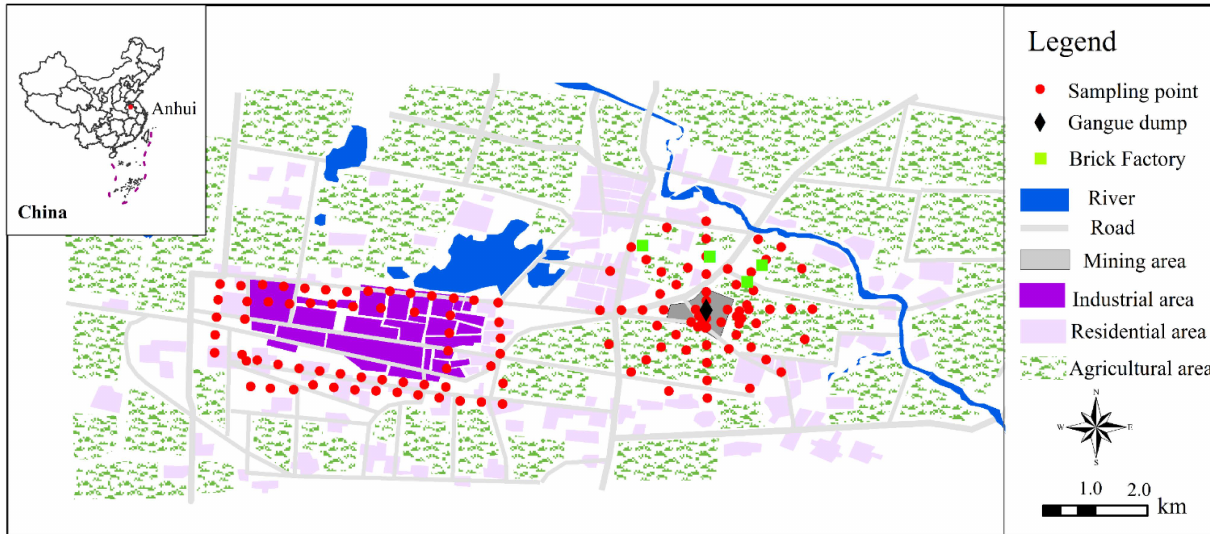
Figure 1. Geographical location of the research area and distribution of sampling